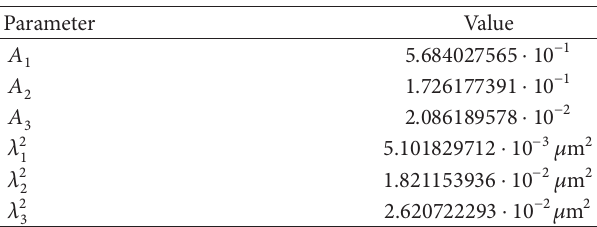
Table 2: Sellmeier parameters for water